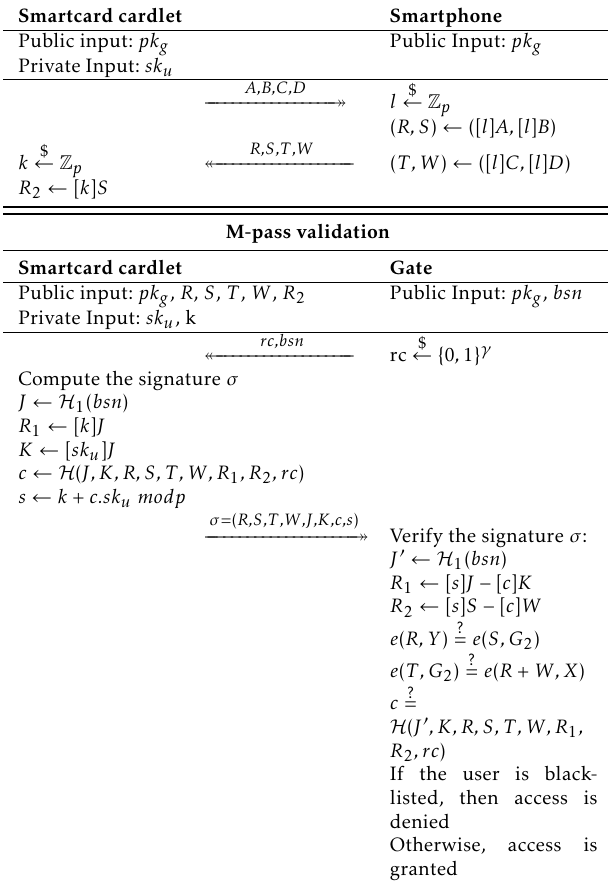
Table 2. Protocols for the validation